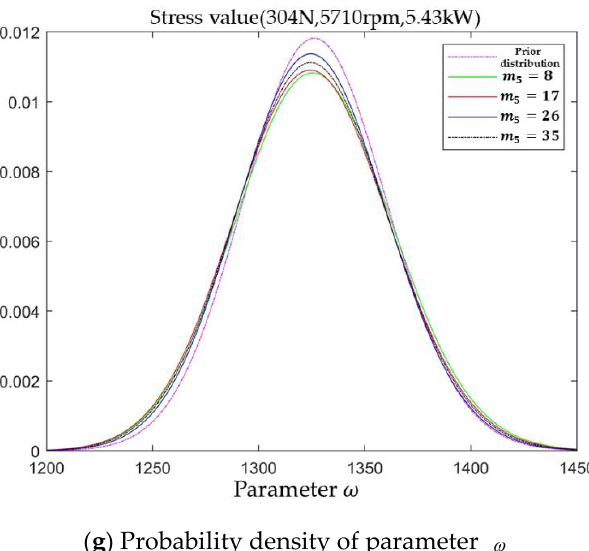
Figure 9. The update process of probability density of each model parameter with the test ( l = 5). Compared with the probability density function plots of the posterior distribution of model parameters at the first two stress levels, the shifting of the probability density func- tion of the posterior distribution of each model parameter in Figure 9 is basically elimi- nated, and the fluctuations are mainly the up and down fluctuations of the function im- ages, i.e., the changes of the variance of the posterior distribution. It indicates that the mean value of the posterior distribution has been close to the true value of the model parameters, but it is necessary to continue the test because the function graph is not stable. When the stress level l = 5 ends, IG = 87.661 > EIG = 32.2650, which satisfies the sequential truncation basis for the next stress level, the test of stress level l = 4 is carried out according to the selected test plan. In addition, the variation of the probability density of the poste- rior distribution of each model parameter with the performance degradation increment y under this stress level is shown in Figure 10. data 4